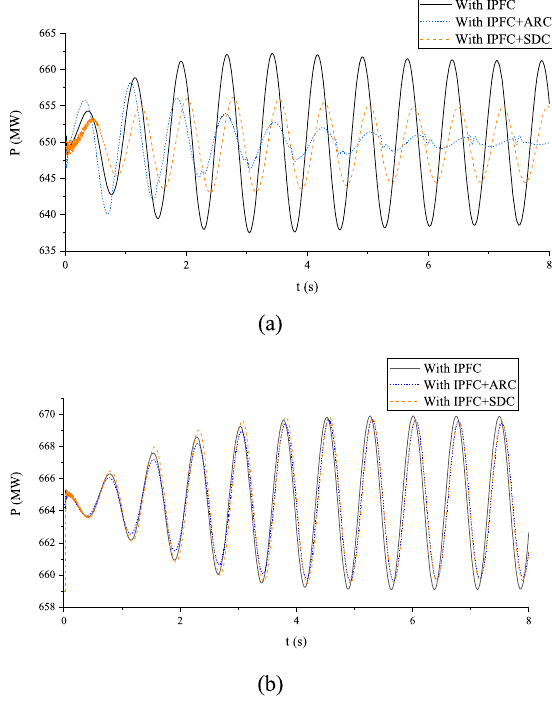
Fig. 12 Forced oscillation in transmission line: a Simulation results of P ik ; b Simulation results of P jl